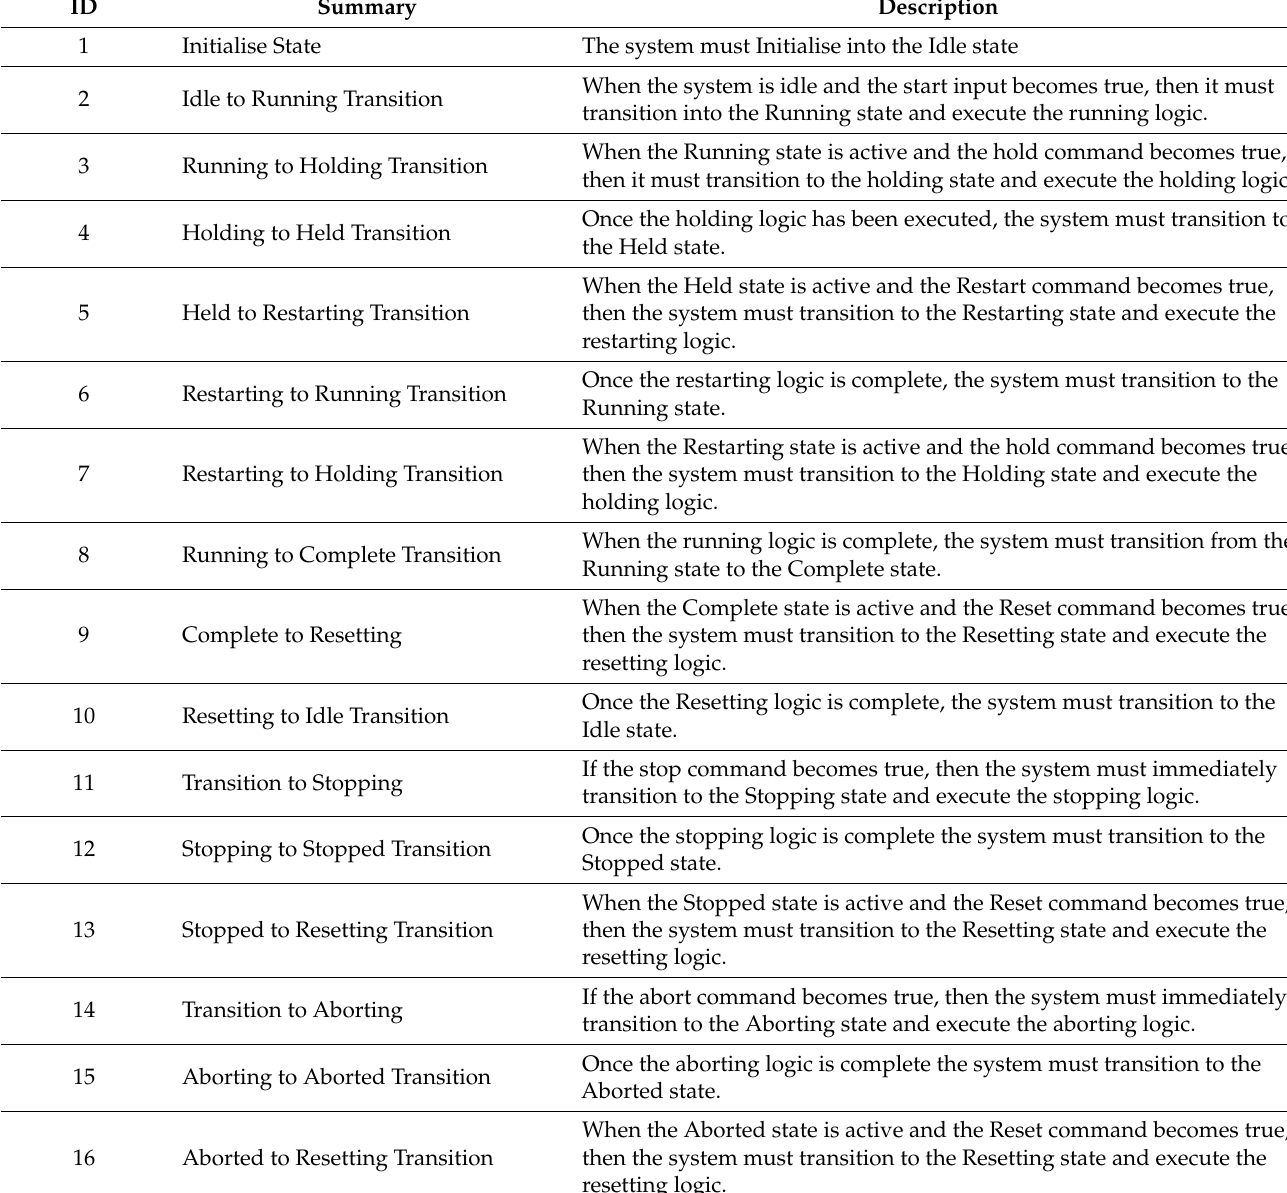
Table 3. Summary of sixteen functional requirements describing the model